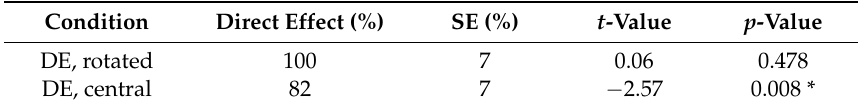
Figure 2. ( a ) Prism adaptation and direct effect; ( b ) Readaptation and aftereffect. Black dots show the results for the rotated chair position and grey triangles the averaged results for the central chair position. Error bars denote SEs. Y-axis: horizontal deviation of the averaged pointing movements from the central target (y = 0), the red bar indicates the optical power of the prisms. X-axis: number of pointing movements performed. * with bar indicates a significant difference ( p ≤ 0.05) of the first movement between central and rotated chair condition, hence a difference in the immediate correction effect. As is normal in prism experiments, the aftereffect is much smaller than the direct effect, probably due to the fact that the unconscious head rotation disappears when the prisms are removed. Table 2. Comparison between direct effect (DE) and prismatic power in the dark. One-sided t -test against 100 percent (=optical power of the prisms). Condition